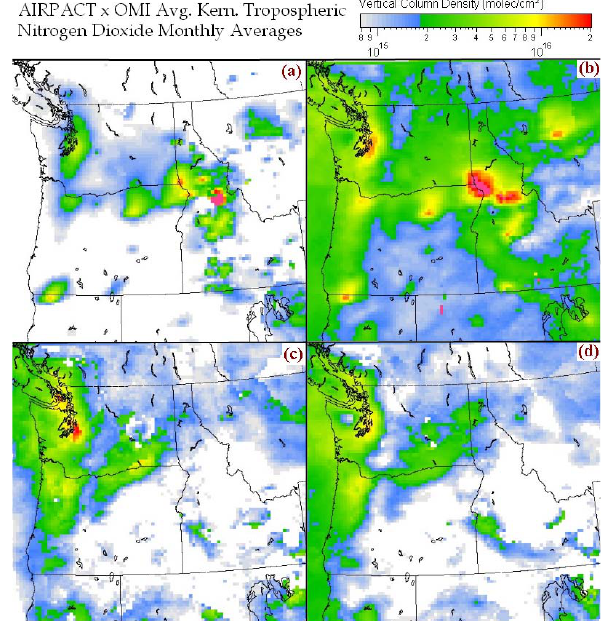
Fig. 14. Tropospheric NO 2 columns with the daily averaging ker- nels from OMI applied to AIRPACT are shown for summer (July, 2007) and winter (January 2008) monthly averages: AIRPACT × KNMI AK for July 2007 (a) at upper left, AIRPACT × NASA AK for July 2007 (b) at upper right, AIRPACT × KNMI AK for Jan- uary 2008 (ac) at lower left, and AIRPACT × NASA AK for Jan- uary 2008 (d) at lower right. The pink color denotes values over 2 × 10 16 molecules per square